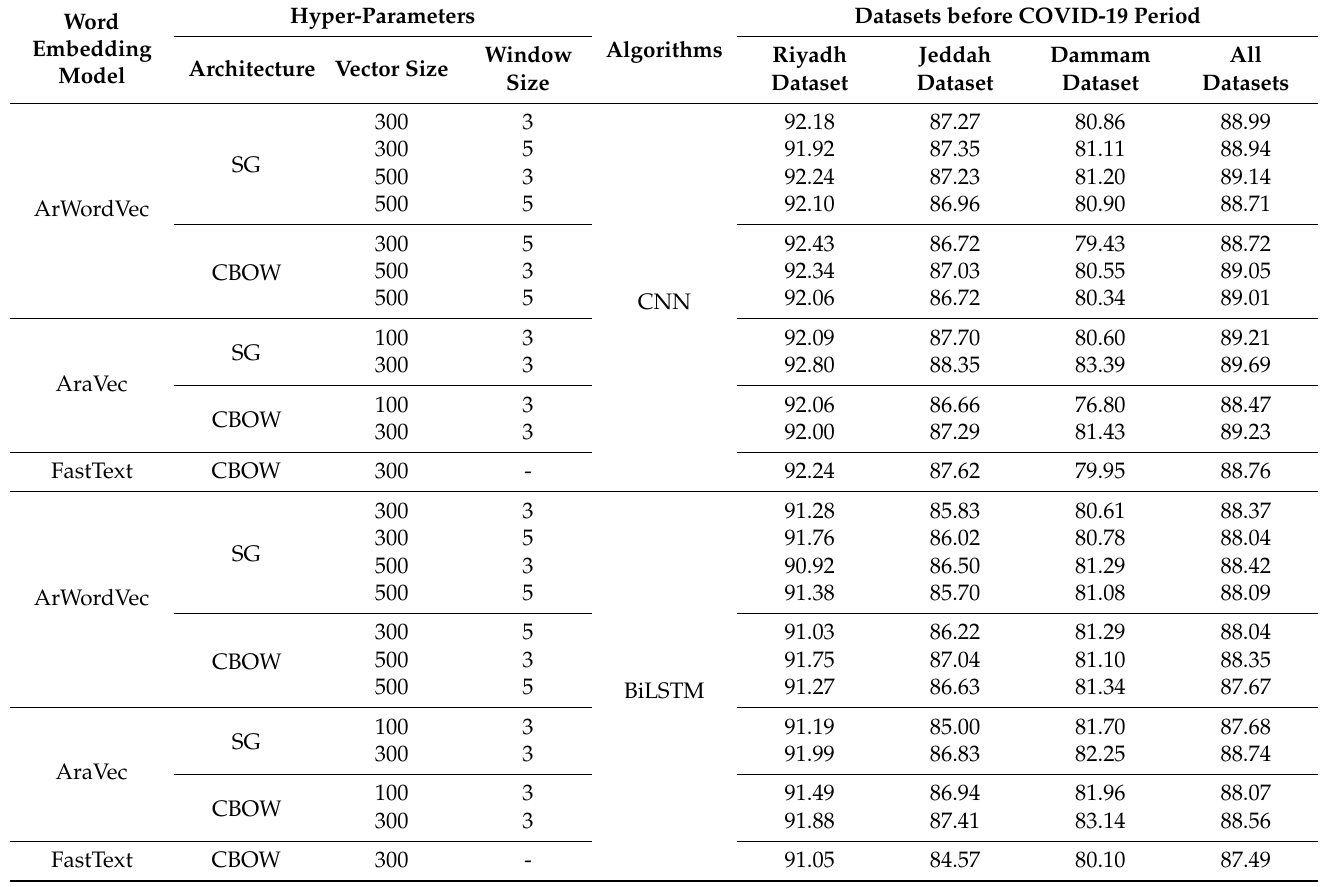
Table 7. The accuracy metric of CNN and BiLSTM algorithms when using different Arabic pre-trained word embedding techniques for dataset before COVID-19.